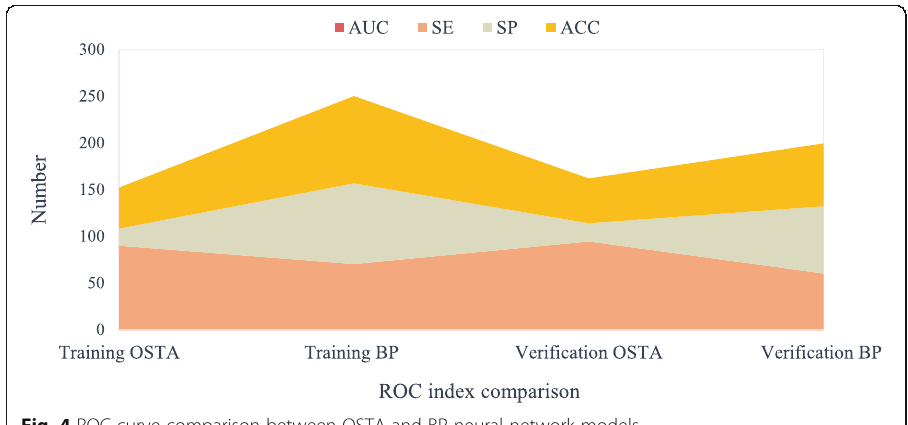
Fig. 4 ROC curve comparison between OSTA and BP neural network models